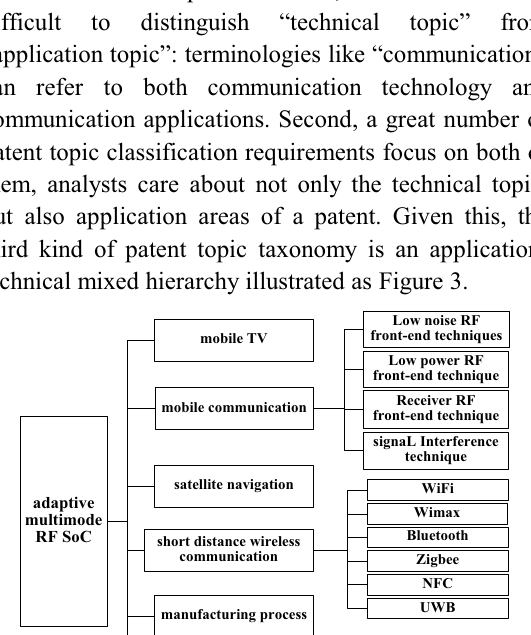
Fig.4. Automatic classification processes of patent classification to a requirement-oriented taxonomy using supervised machine learning